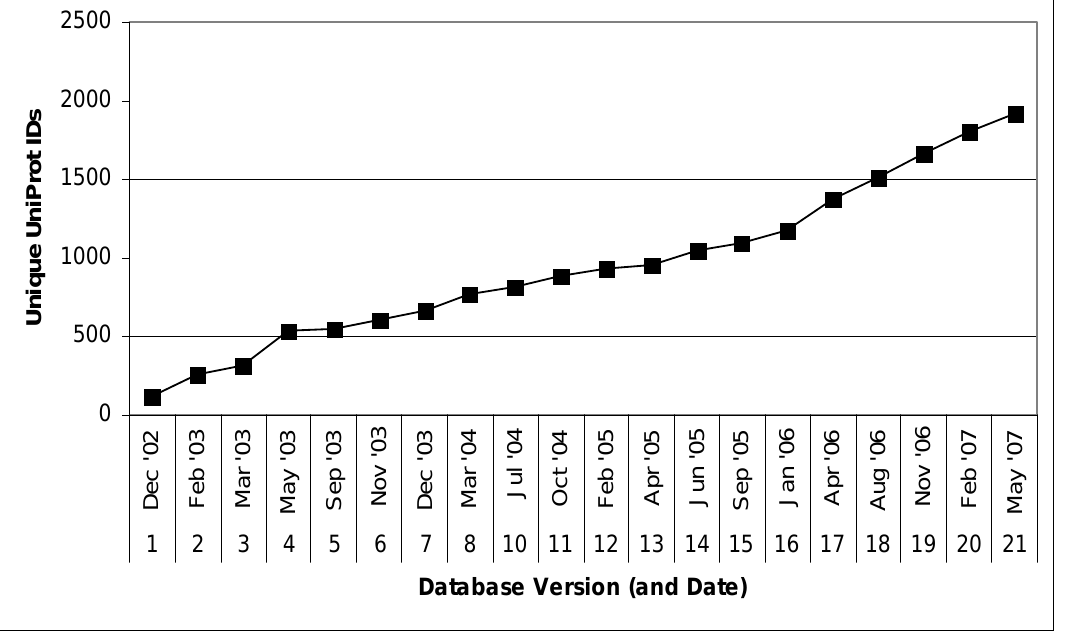
Figure 4: The expanding coverage of the published Reactome human model in terms of unique UniProt Accession IDs over the past 21